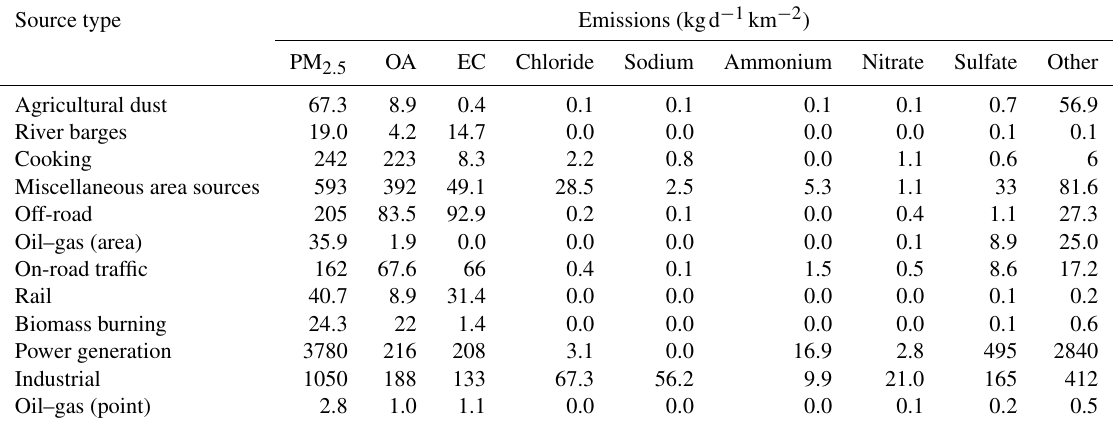
Table 2. PM 2 . 5 emissions by source for the 1 × 1km Pittsburgh domain (July